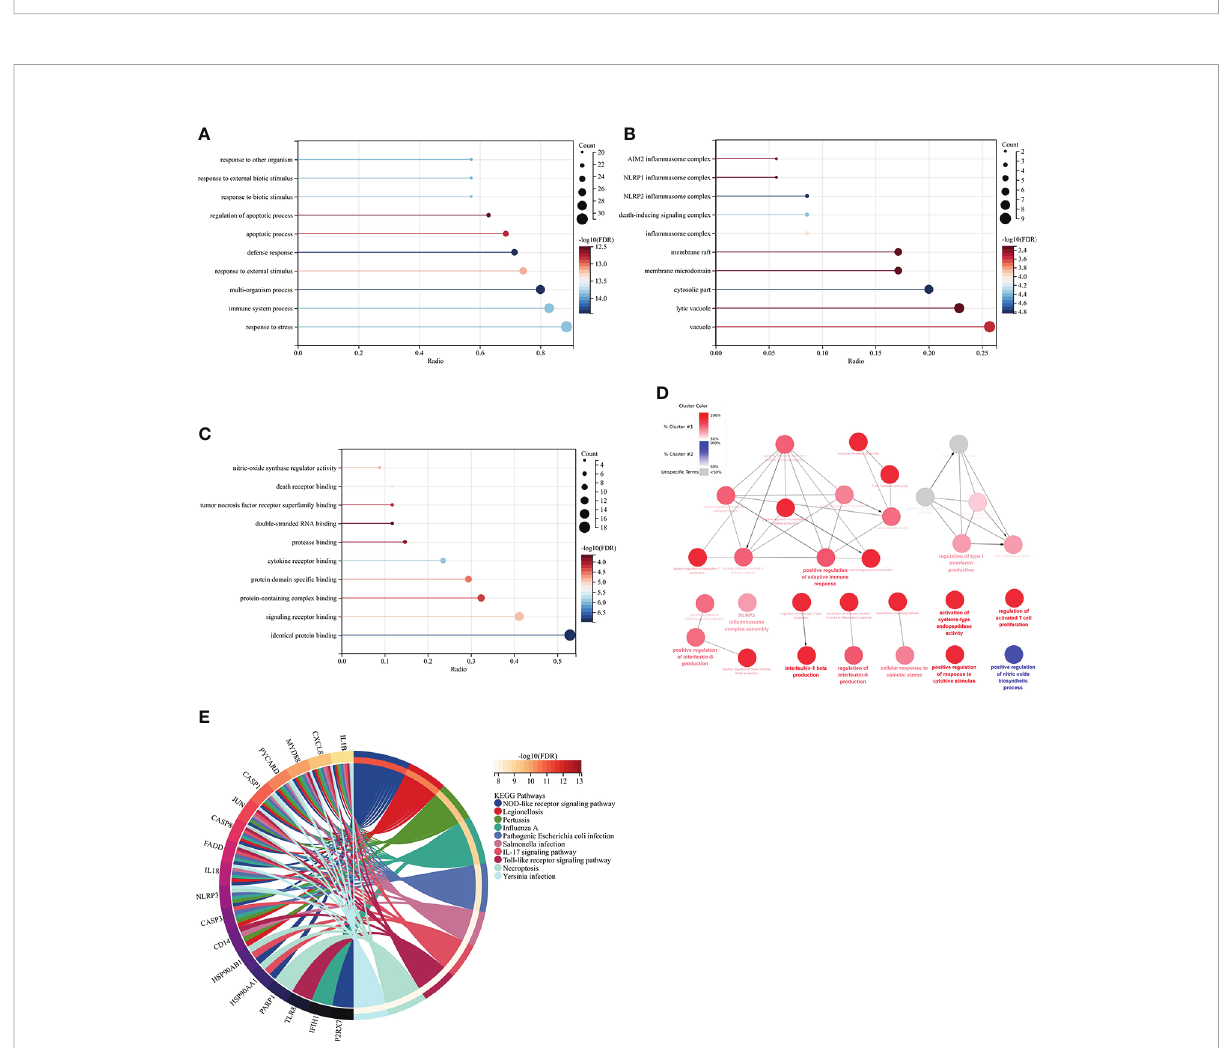
FIGURE 5 Co-genes functional enrichment analysis using GO, ClueGO, and KEGG. (A) Enrichment of Co-genes in BP. (B) Enrichment of Co-genes in CC. (C) Enrichment of Co-genes in MF. (D) Co-genes Analysis Using ClueGO. Red-denoted pathways for upregulated genes, while blue-denoted pathways for downregulated genes. (E) Co-genes Analysis Using